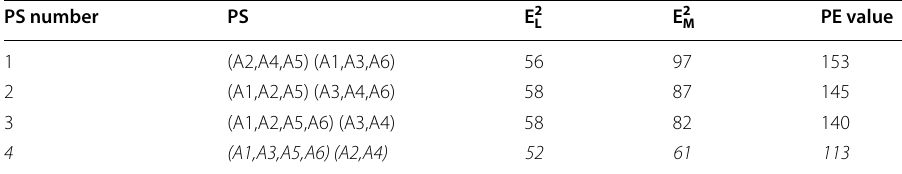
Table 23 Fragmentation evaluation (proposed work of this paper) PS number PS